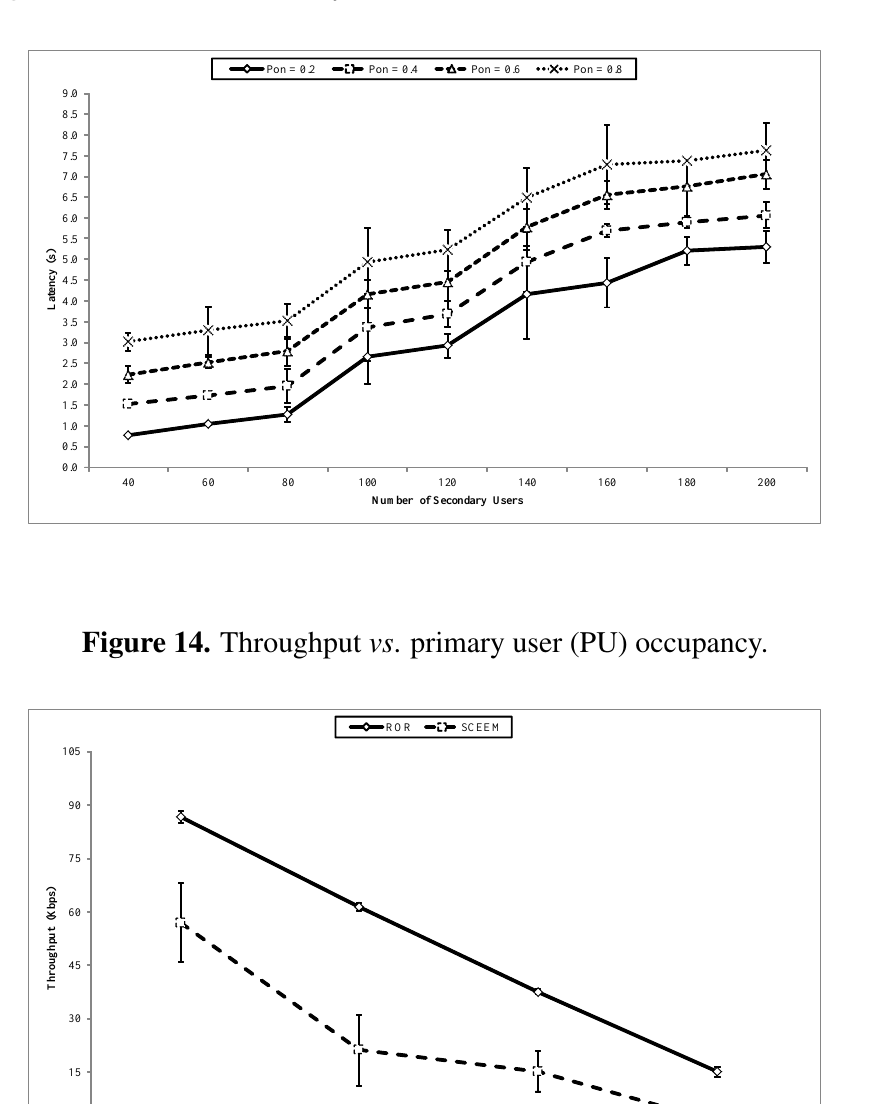
Figure 13. End-to-end latency vs . number of CRSN nodes in the network.